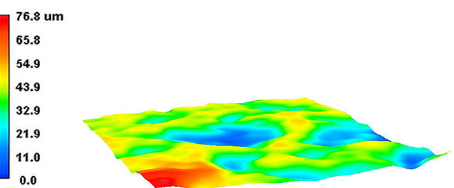
Figure 19. The 3D wear morphology of the WC-12Co coating.